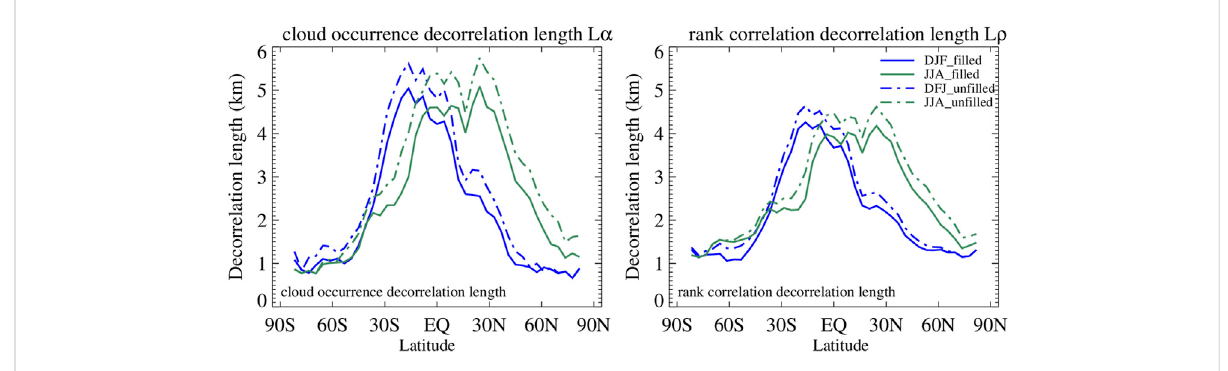
FIGURE 5 Zonal variation of mean ρ , thecorrelation coef fi cient of COD ranks betweencloudy layers, as a function of their separation distance Δ z , for DJF (left panel) and JJA (right panel) from the fi lled COD O22 dataset.